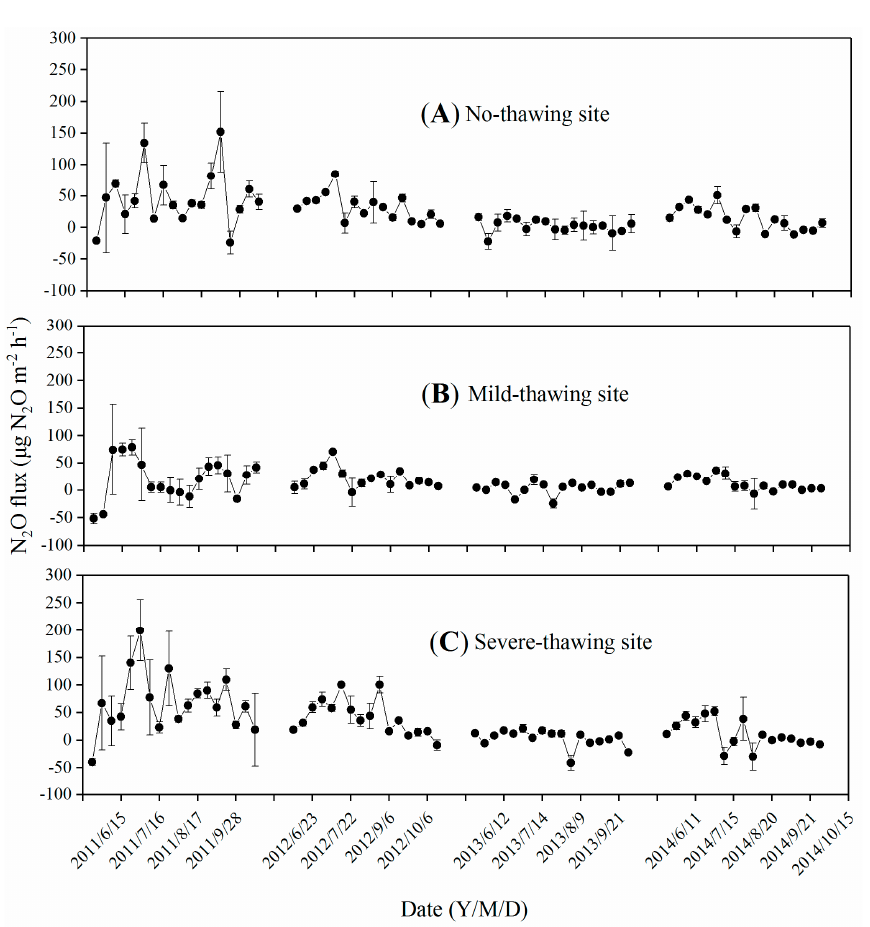
Figure 7. Seasonal variation of N 2 O fluxes in no-thawing ( A ), mild-thawing ( B ) and severe-thawing ( C ) sites. Data are means ± SE. n = 3 for the no-thawing site, n = 4 for the mild-thawing and severe-thawing sites. Table 3. Correlations between N 2 O flux and environmental factors.